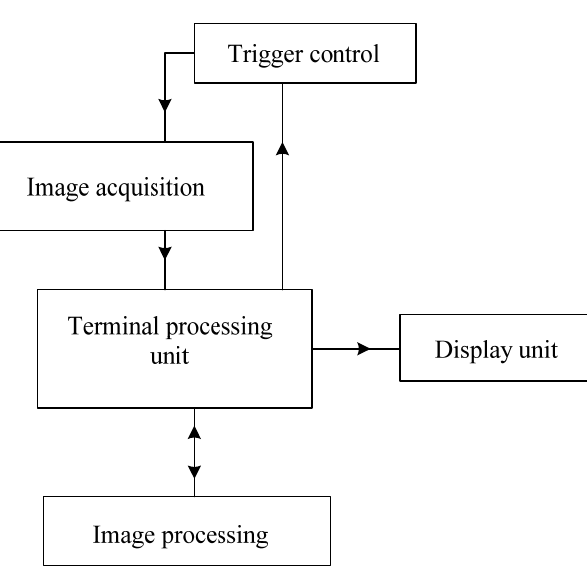
Figure 6. Image processing flowchart.